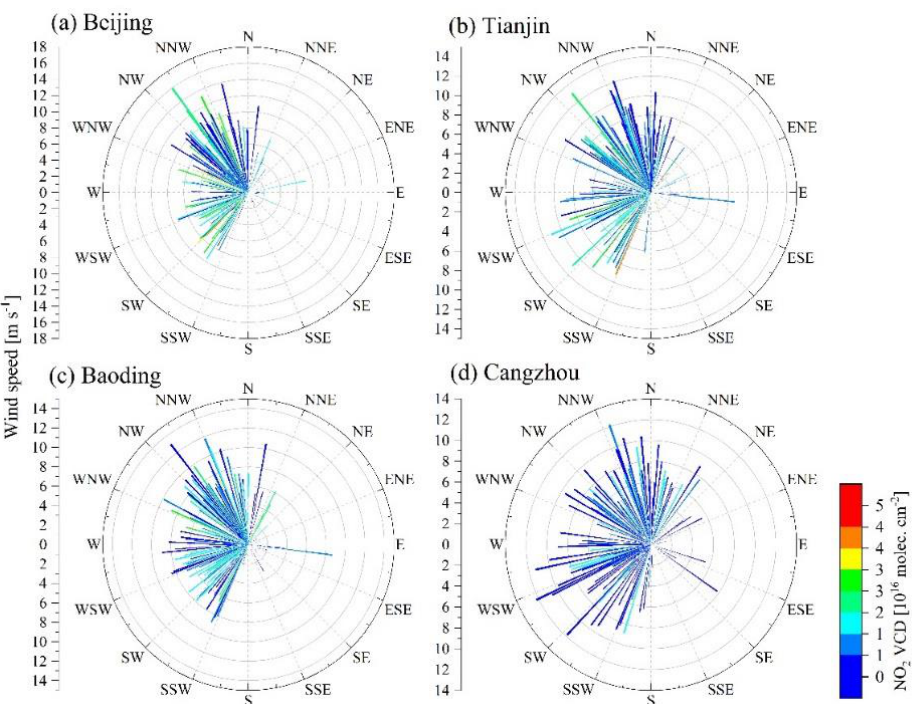
Figure 8. Wind rose for the wind field and NO 2 columns in ( a ) Beijing, ( b ) Tianjin, ( c ) Baoding, and ( d ) Cangzhou during the period ranging from 1 November 2018 to 30 April 2019. Table 4. Two-way analysis of variance of wind fields in Beijing, Tianjin, Cangzhou, and Baoding. Sites Wind Speed Wind